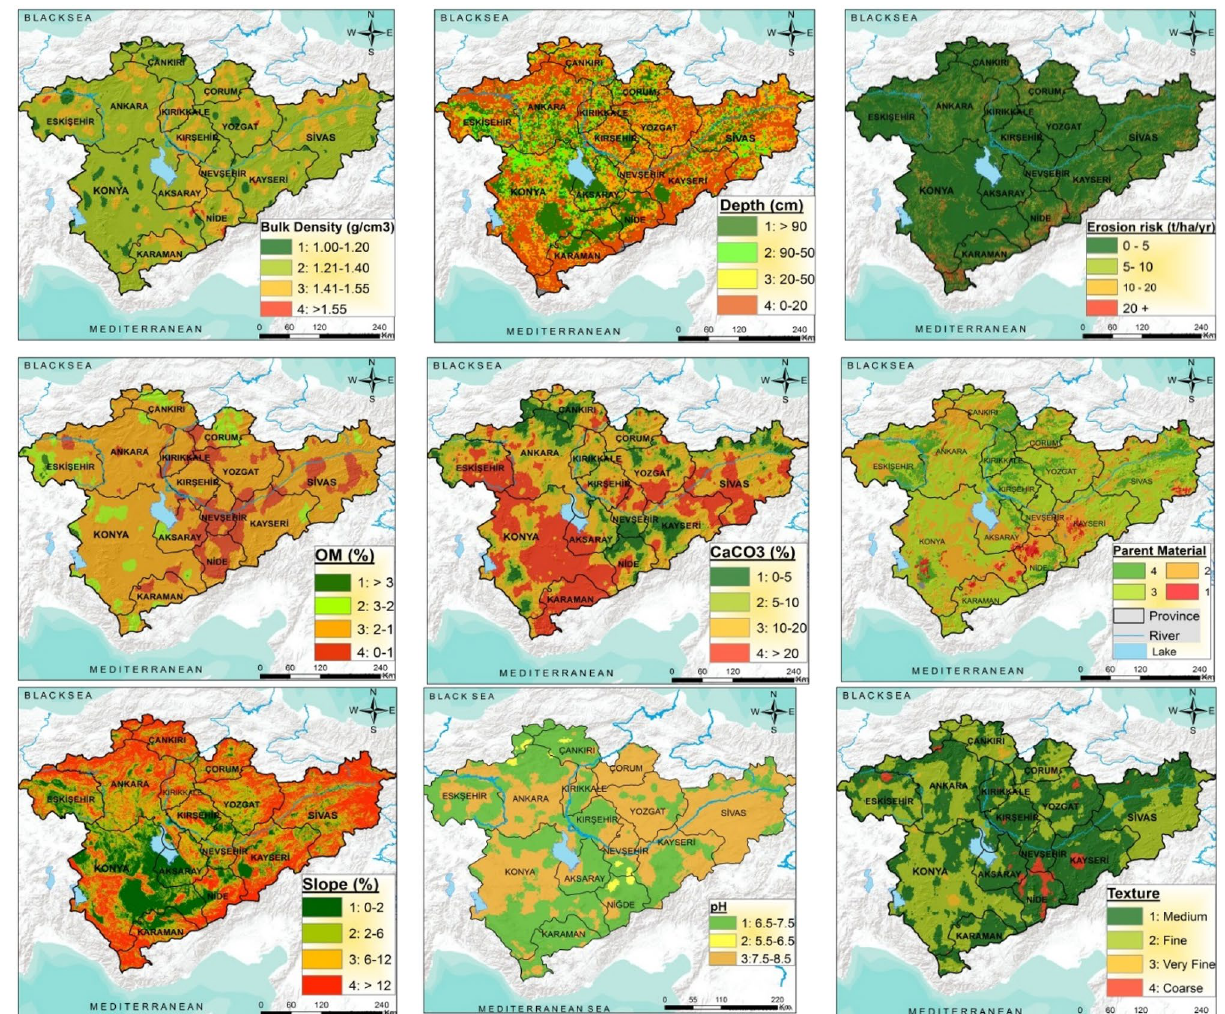
Figure 4. Spatial distribution of some criteria for land suitability for agriculture usages (the maps were created by the authors using the ArcGIS 10.2,